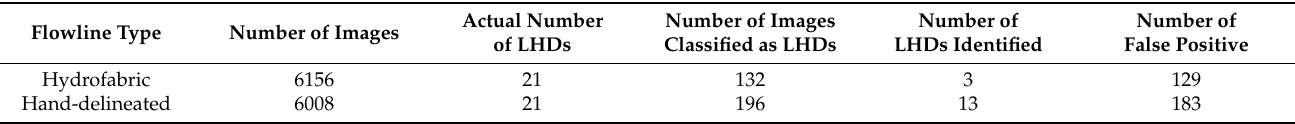
Table 2. Summary of the comparison between the Hydrofabric and the hand-delineated flowlines in the Provo River watershed.